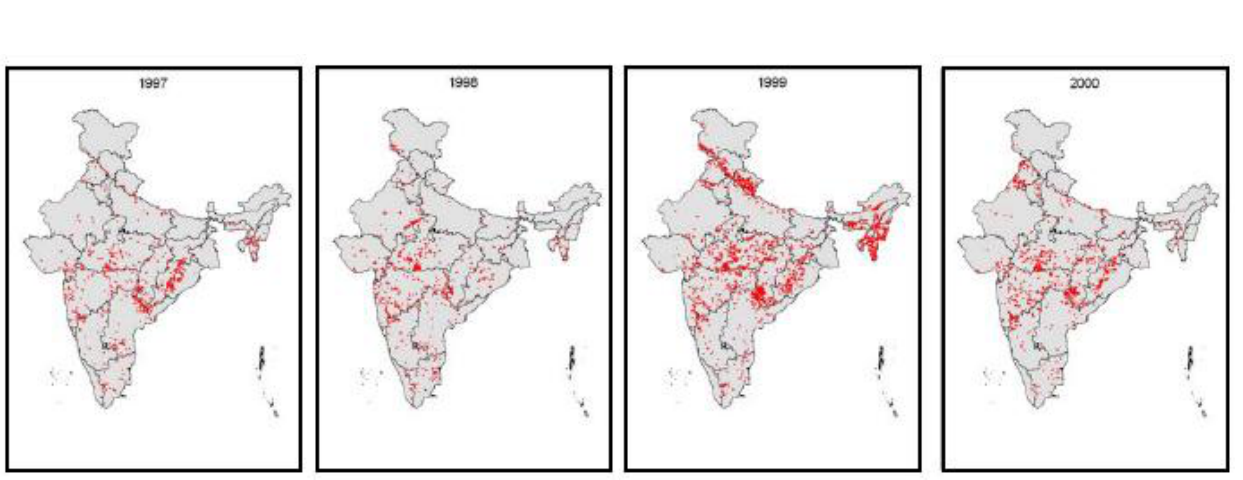
Figure 2. Distribution of forest fire using A(A)TSR data over Indian sub-continent between 1997 and